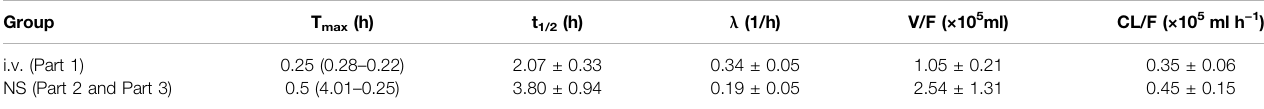
TABLE 4 | Pharmacokinetic properties of dexmedetomidine in healthy subjects in the i.v. group or NS group. Group T max (h)